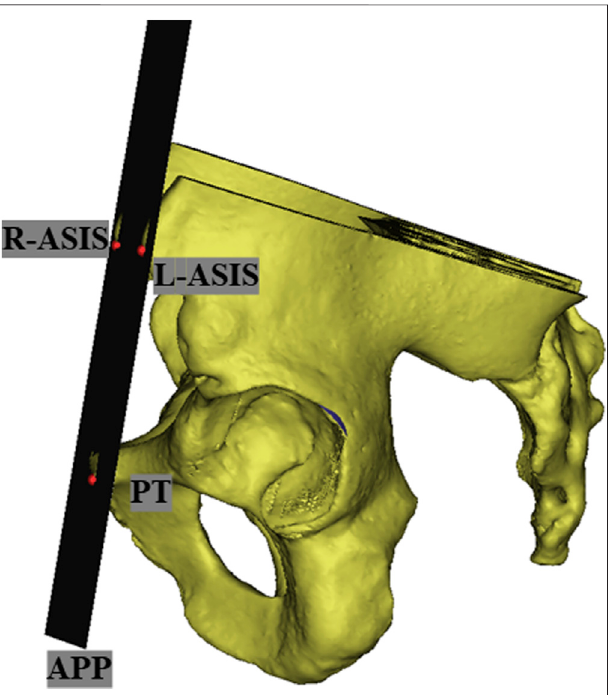
FIGURE 1 | In the three-dimensional simulation, according to the left anterior superior iliac spines (L-ASIS), right anterior superior iliac spines (R-ASIS), and pubic tubercles to determine the anterior pelvic plane (APP).